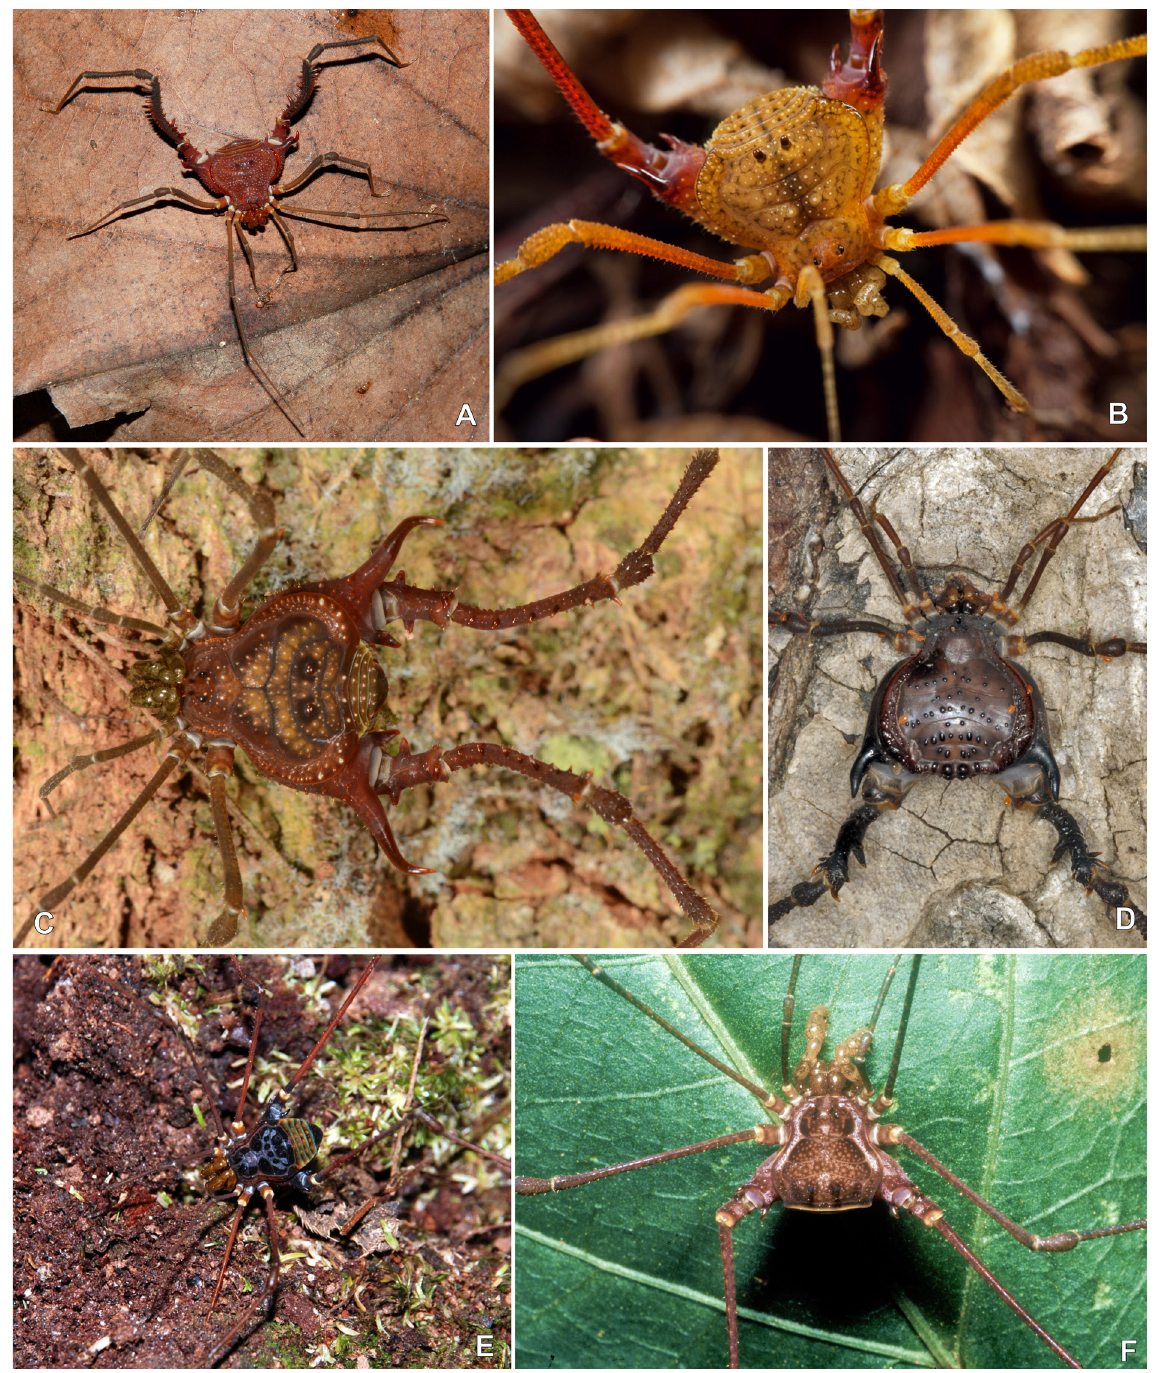
Fig. 10. Male specimens of Discocyrtus , ex- Discocyrtus , Mitobatinae, ex-Mitobatinae, Pachylinae and ex-Pachylinae, in vivo. – Roeweriinae. A . Discocyrtanus pertenuis (Mello-Leitão, 1935), Brazil, Minas Gerais, Belo Horizonte. B . Roeweria virescens (Mello-Leitão, 1940), Brazil, São Paulo, Piedade. – “Pachylinae”. C . Discocyrtus crenulatus Roewer, 1913, Brazil, Rio de Janeiro, Taquara. – Pachylinae. D . Pachylus chilensis (Gray, 1833), Chile.– Mitoblatinae. E . Discocyrtoides nigricans (Mello-Leitão, 1922), Brazil, Minas Gerais, Ouro Preto, and F . Longiperna concolor (Mello-Leitão, 1923), Brazil, São Paulo, Ubatuba. Images courtesy Arthur Anker & Pedro Martins (A, C, E), João Burini (B), Ricardo Pinto-da-Rocha (D) and Glauco Machado